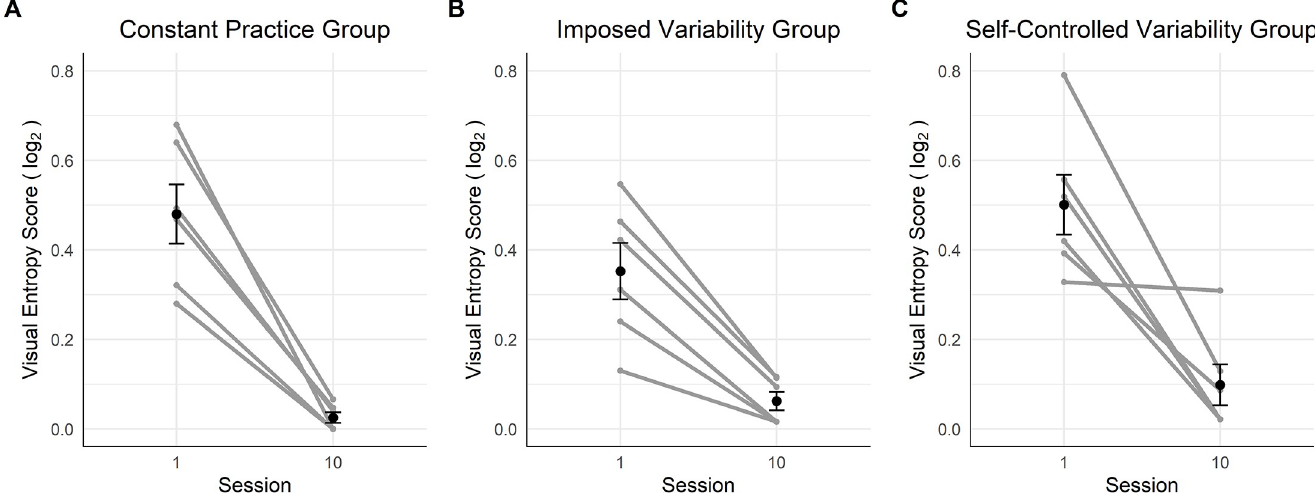
Fig 3. Dynamics of the visual entropy score on the first and last session for the three groups. The black points represent the sessions mean and the error bars their standard error. The grey points and lines represent each participant’s dynamics.